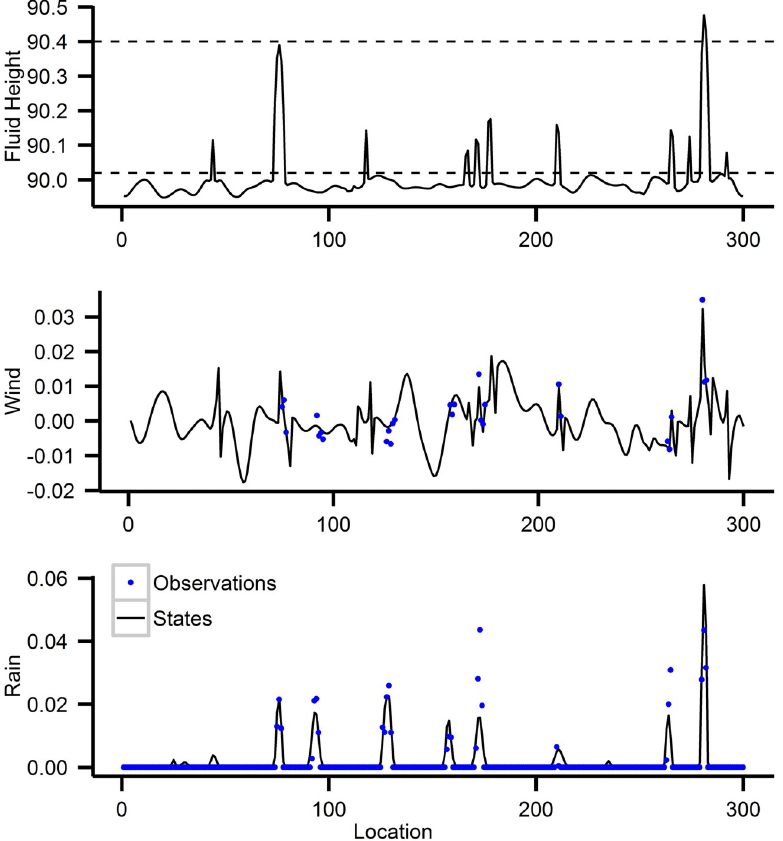
Fig 3. Fluid height, rain, and wind at 300 different locations at an instance of time. The blue dots are observations; rain is always observed, wind is only observed when the rain is non-zero, fluid height is never observed. The dashed lines in fluid height are the cloud and rainwater